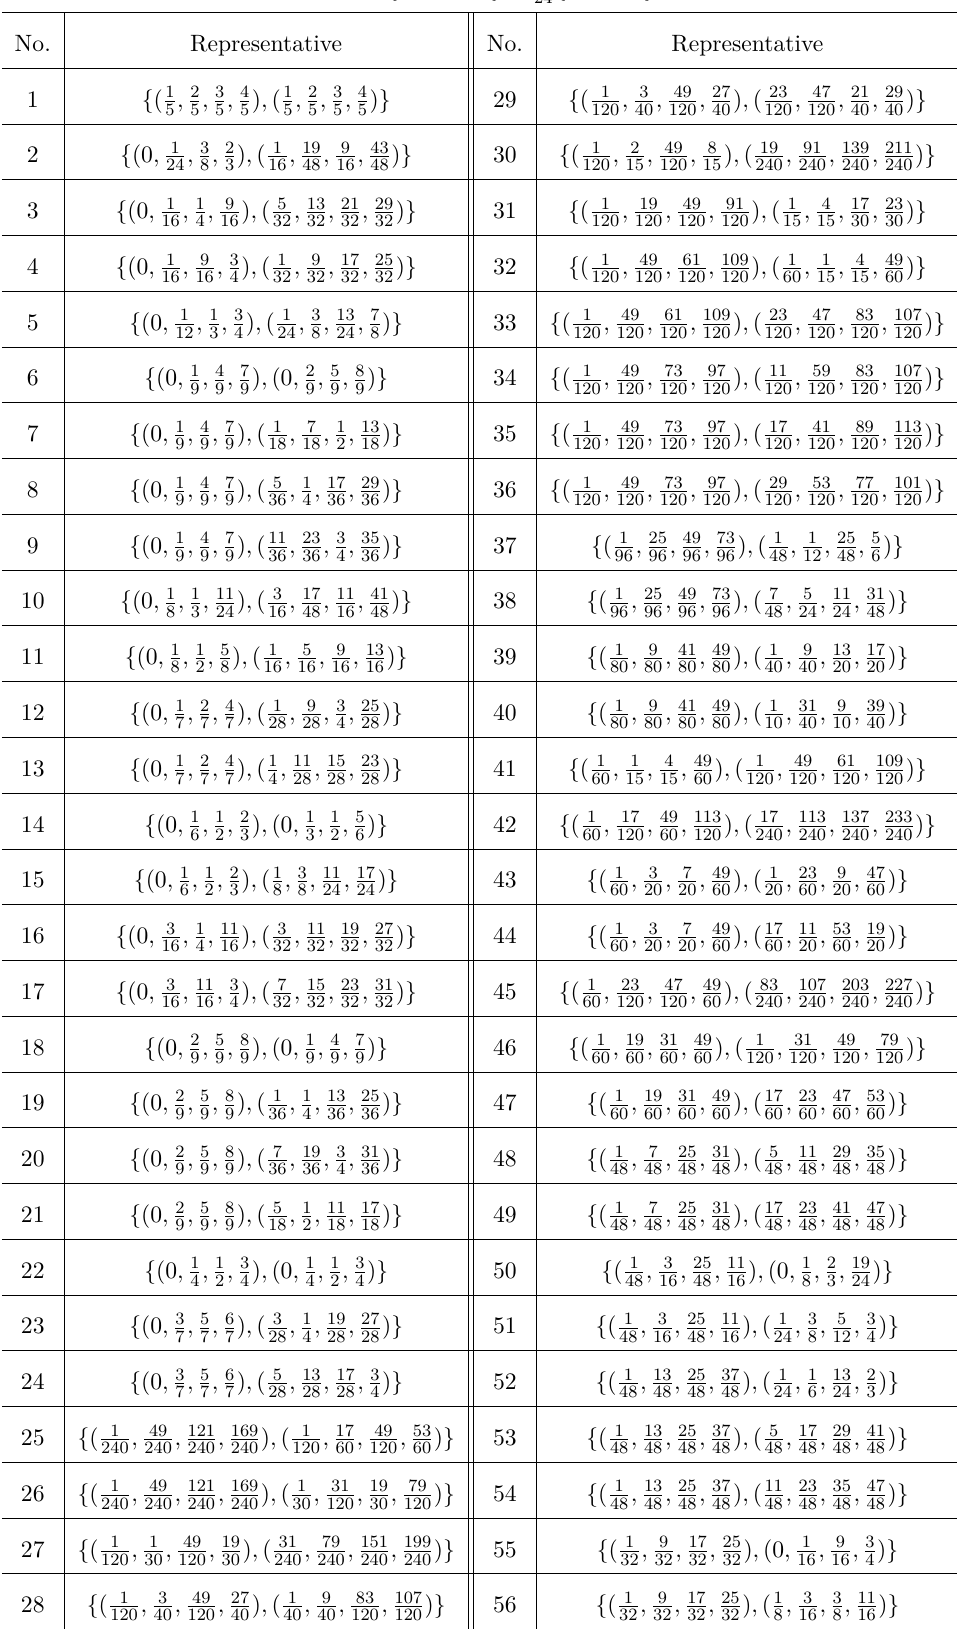
Table 10 . All possible exponents mod 1 for rank 4 non-degenerate FRCFTs. – 27